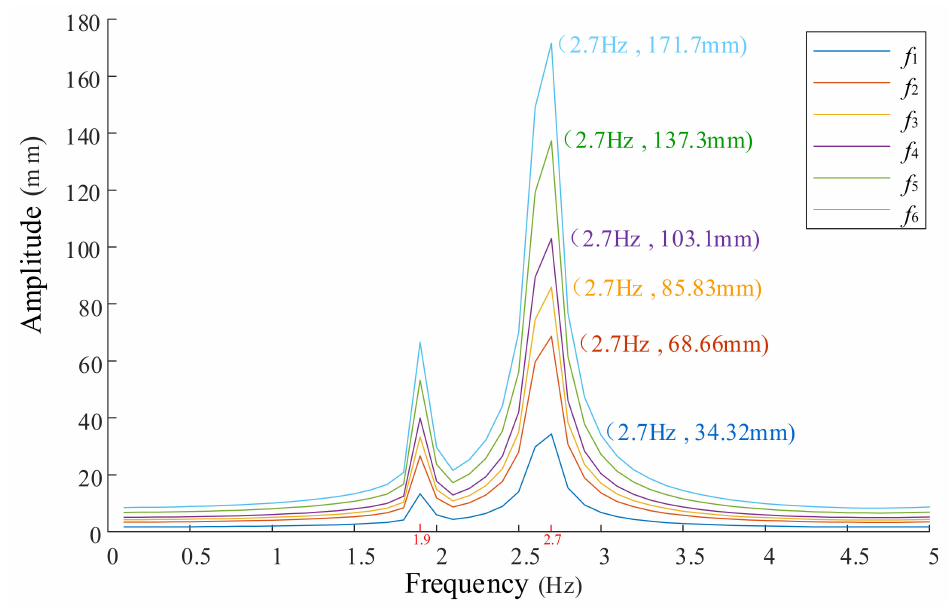
Figure 5. The vibration amplitude of the large